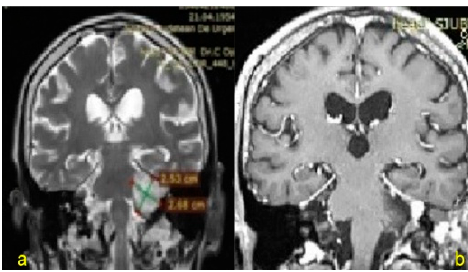
Figure 2. Left vestibular schwannoma, 3rd patient, preoperatory ( a ), and prior to anastomosis ( b ). (4) Progression-free status for previousmalignancies.